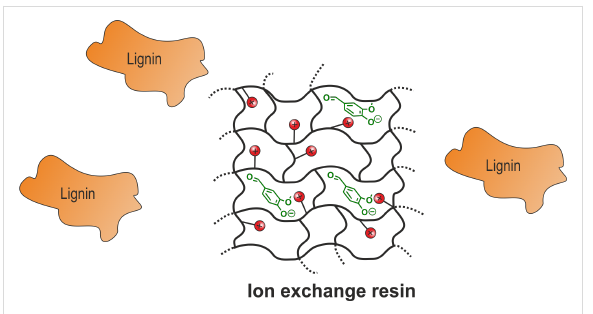
Figure 9: Adsorption of vanillin ( 1 ) on anion exchange resins and size exclusion of lignin particles by application of gel type